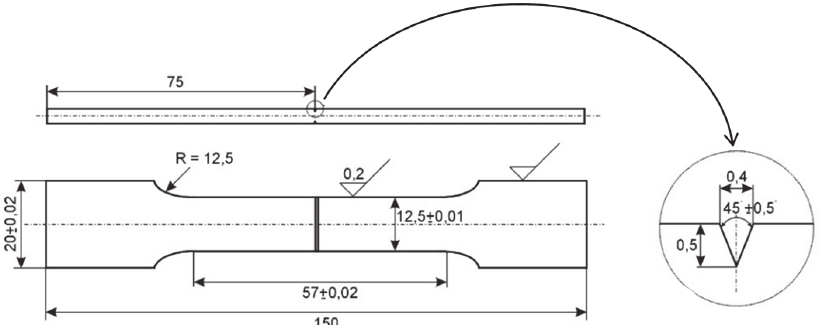
Figure 1: Sketch of the tensile specimen with machined two (upper and lower) surface notches on the large surfaces.